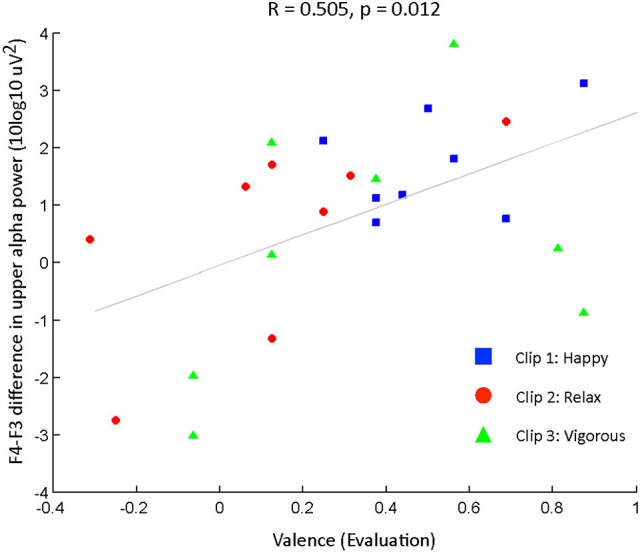
Scatter plot and correlation between evaluation rating (valence) and upperAlpha frontal asymmetry. Upper Alpha power was estimated for the early presentation of clips (10 s), and was log transformed (10log10 uV2). Frontal asymmetry was estimated as the difference of F3-F4 of log transform of upperAlpha band power [10log10(P)]. Pearson's correlation was used (N = 8 subjects).